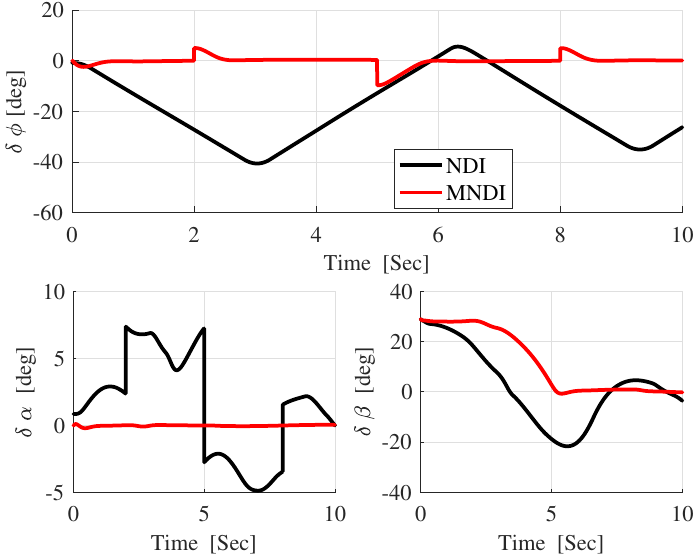
Figure 19. Inner loop rate response for outer roll angle excitation with wind and